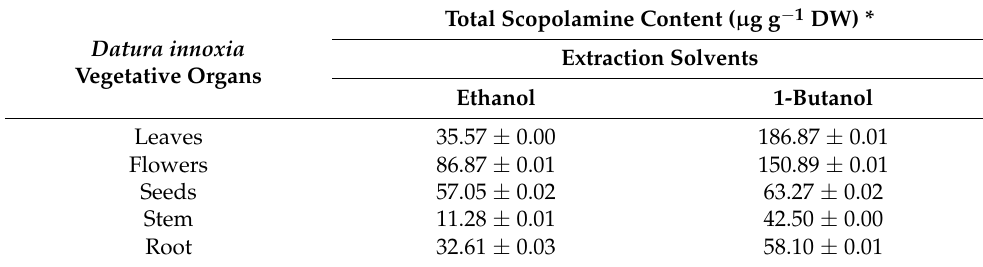
Table 2. Total scopolamine content of dry biomass expressed as µ g g − 1 DW ( n =